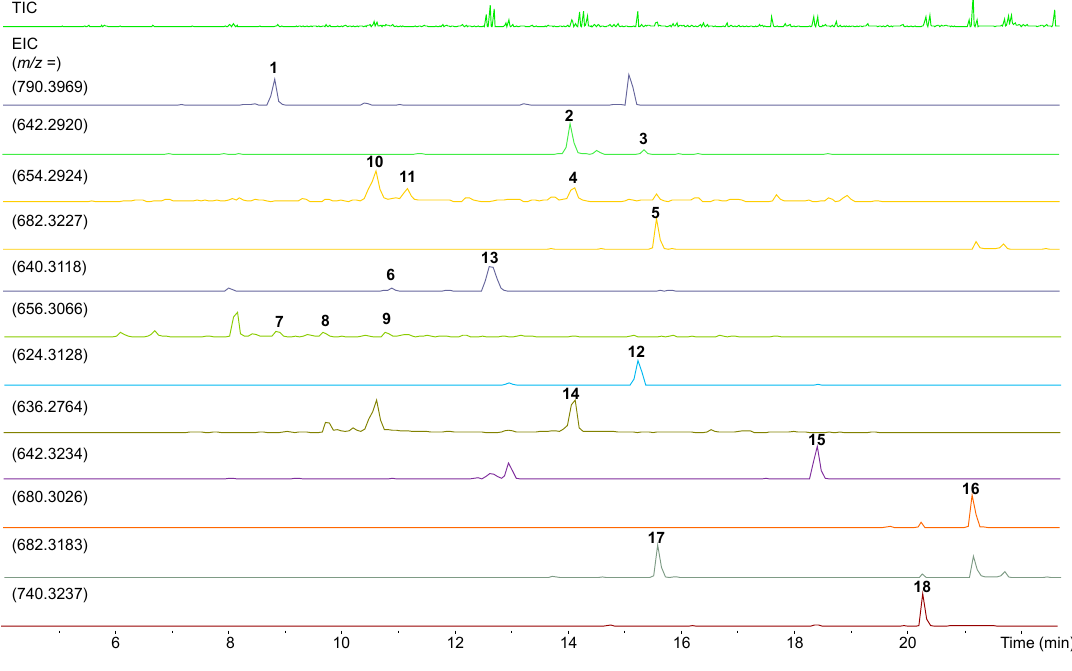
Figure 2. Designation of compound peaks of the A. mediterranei S699 Δ rifT mutant by LC-ESI-HRMS (liquid chromatography-electrospray ionization-high-resolution mass spectrometry). Compound 1 was determined to have the molecular formula C 41 H 59 NO 14 on the basis of the quasi molecular ion peaks at HRESIMS m/z 790.4012 [M + H] + and 812.3817 [M + Na] + (Supplementary